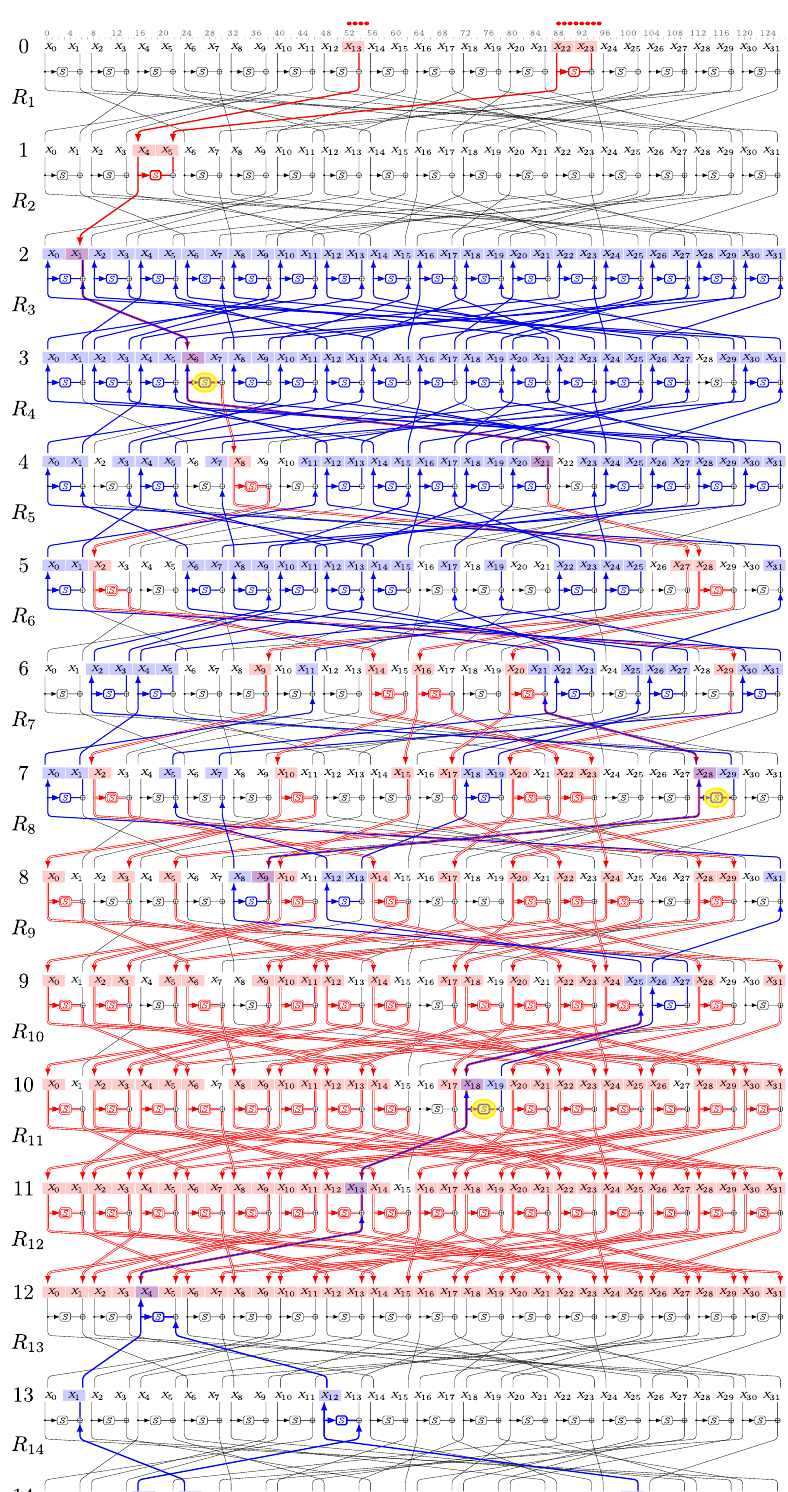
Figure 12: Sandwich distinguisher for 14 rounds of WARP